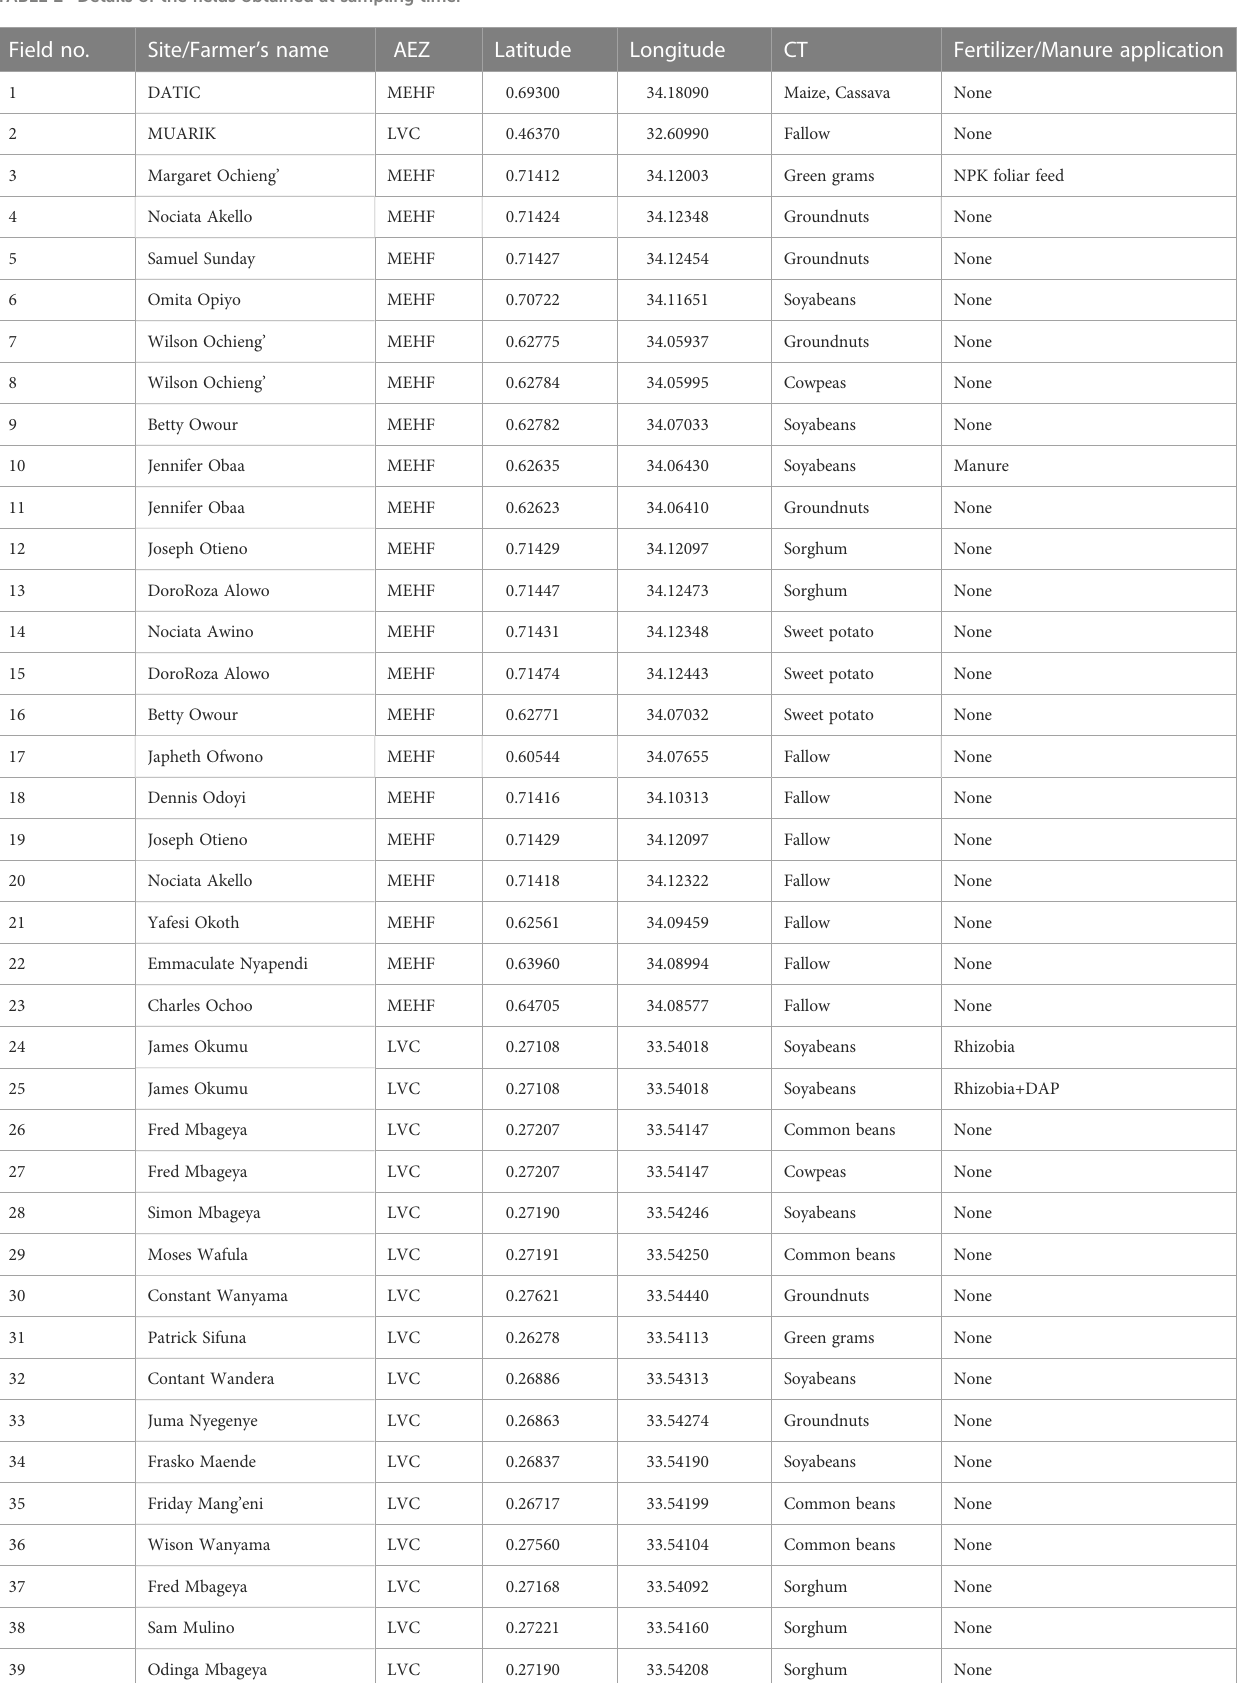
TABLE 2 Details of the fi elds obtained at sampling time. Field